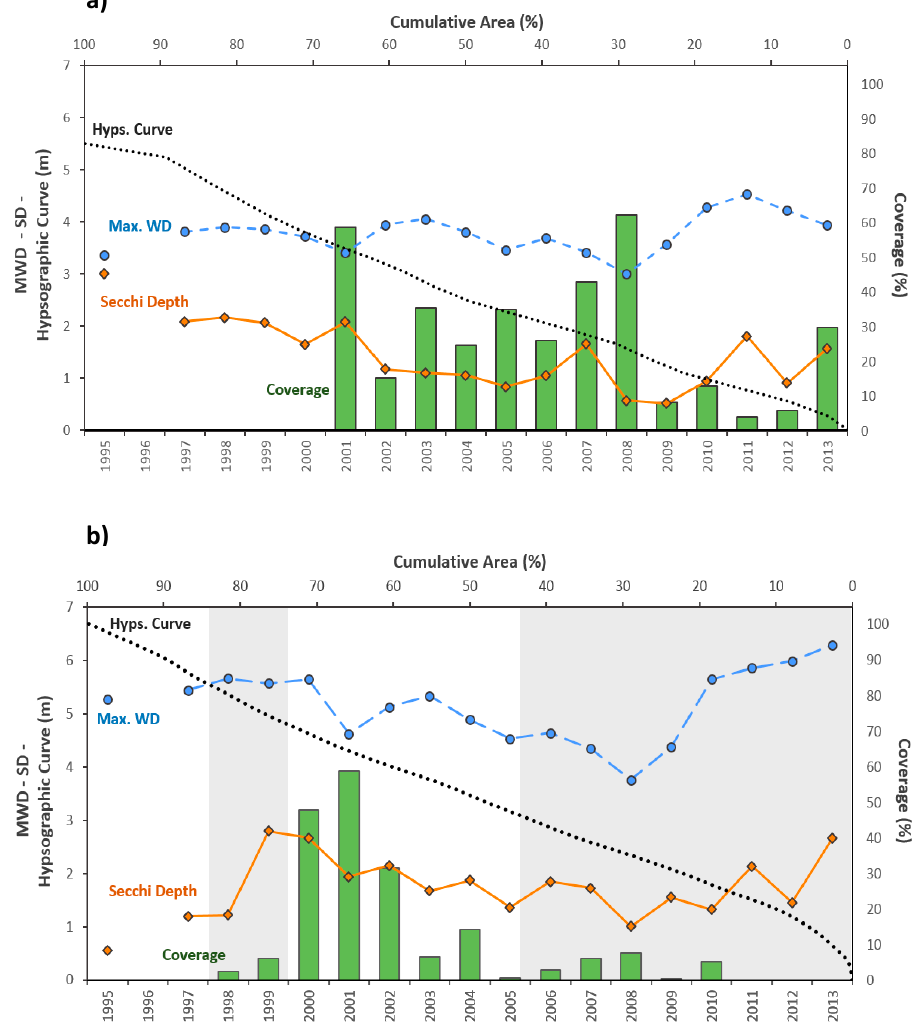
Figure 8. Changes in maximum water depth (MWD), Secchi depth (SD), hypsographic curve and % submerged macrophyte coverage in ( a ) Lake Mogan and ( b ) Lake Eymir (shading indicates the first and second biomanipulation).